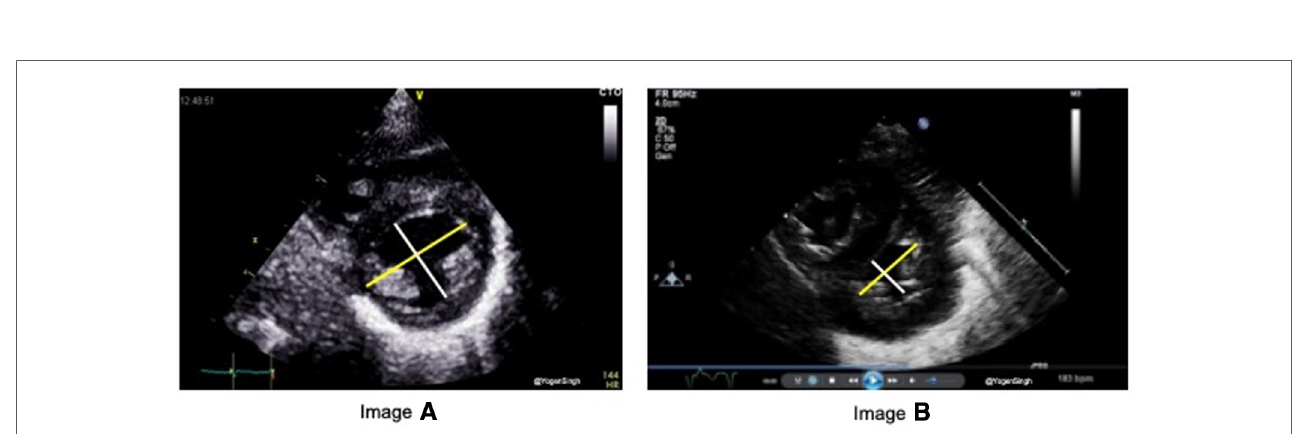
FIGURE 2 Interventricular septum (IVS) and left ventricle (LV) shapes in pulmonary hypertension. Image “ A ” shows normal IVS and LV shape with LV being a circular shaped structure on sweep-PSAX view. Images “ B ” , “ C ” and “ D ” show change in shapes with increasing fl attening of IVS in presence of mild, moderate and severe pulmonary hypertension, respectively.